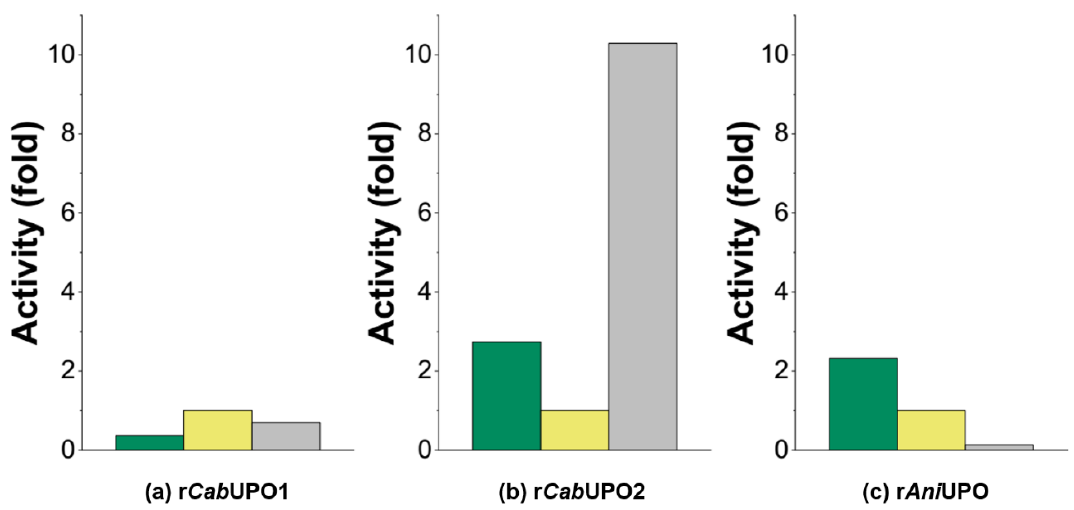
Figure 7. Relative activities of purified rUPO proteins towards ABTS ( ∎ ), NBD ( ∎ ), and VA ( ∎ ). Specific activities were normalized by dividing the specific activity of a respective substrate at pH- optimum by the specific NBD activity at pH-optimum. NBD was chosen for normalization as all enzymes exhibited similar activities (10 – 30 U NBD mg −1 ) towards this substrate (n = 1).